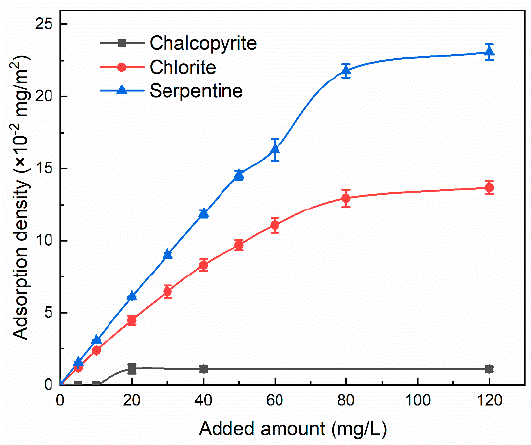
Figure 6. Adsorption density of NaAl on the minerals’ surface as a function of concentration at pH = 9.